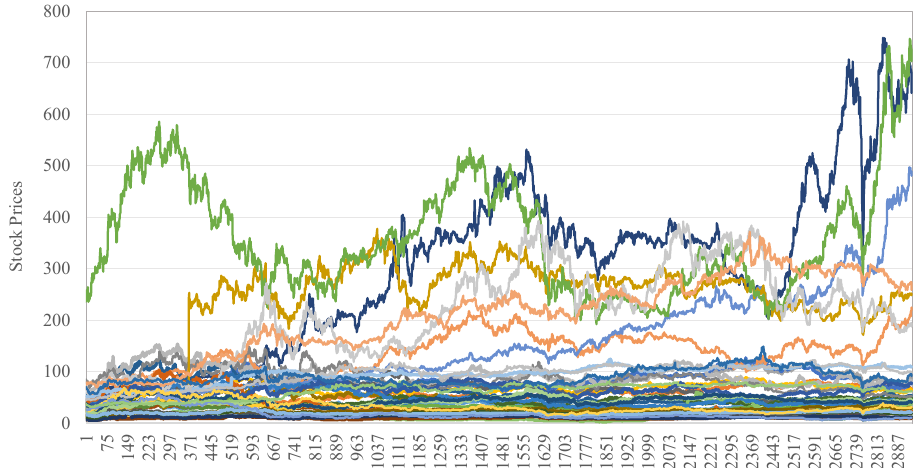
Figure 5. Stock price series of dataset.